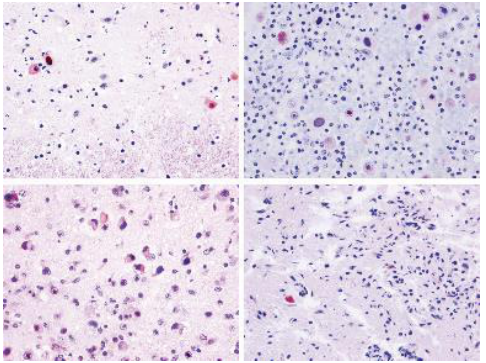
Figure 7 . Immunohistochemistry of Anti-HSV1 in HV-positive brain tissue samples of cases 12, 5, 4, and 11. Inclusion bodies labelled immunopositively for herpesvirus antigen (red colour). Immunohistochemistry counterstaining with haematoxylin.